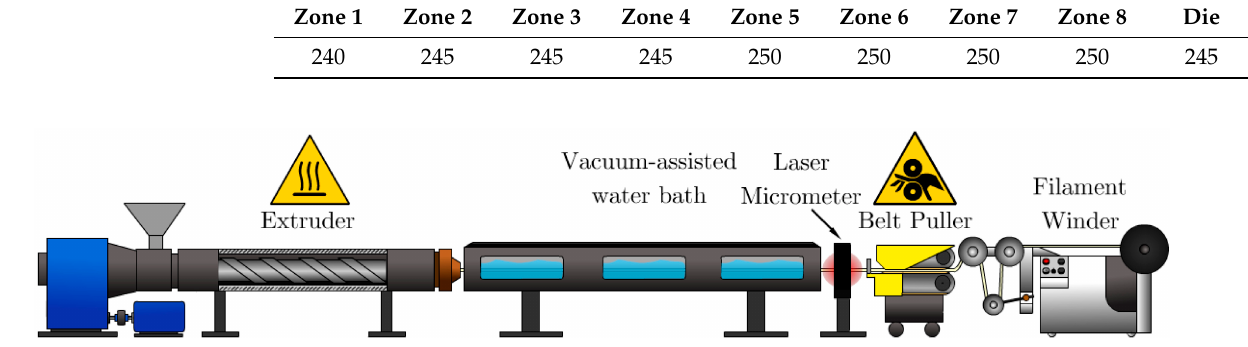
Table 1. Temperature settings in [°C] for the twin screw extruder.